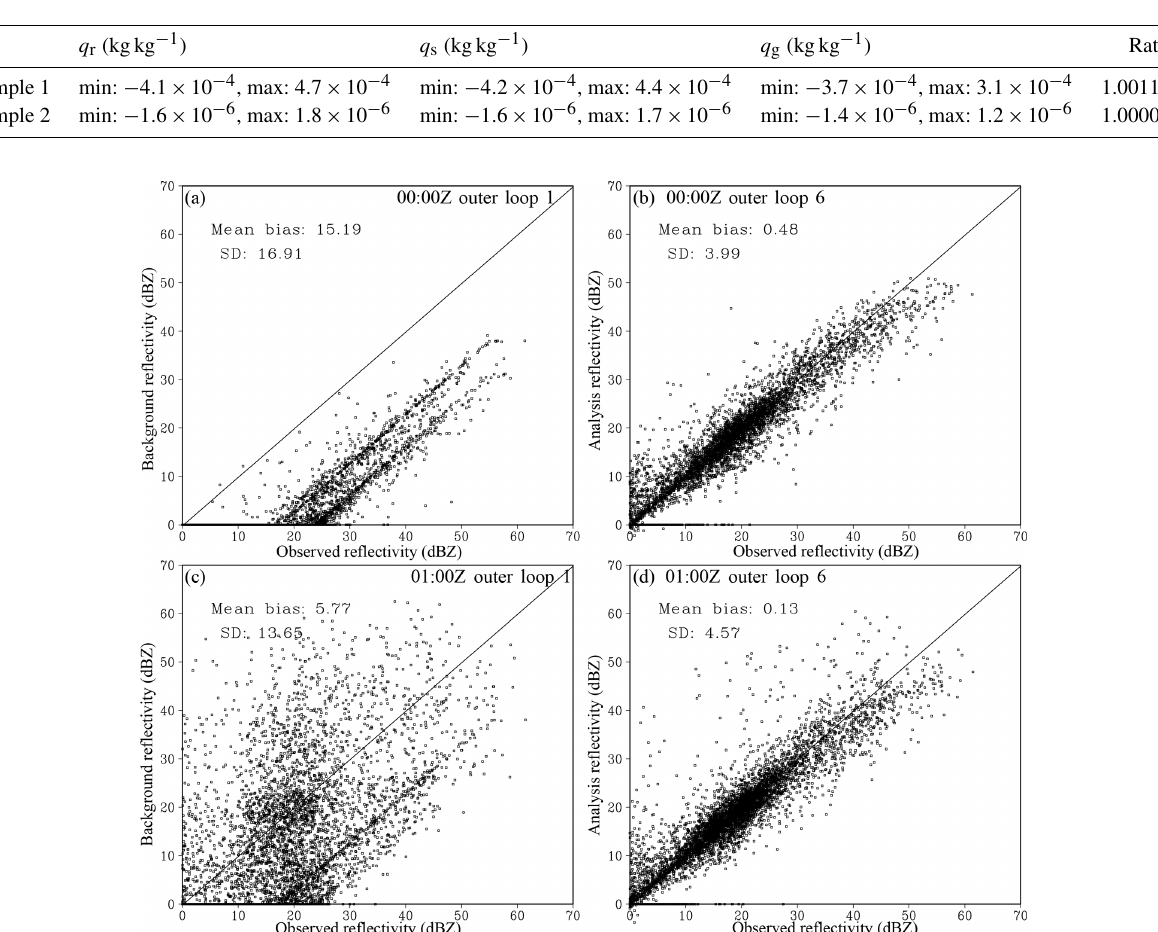
Table 3. Perturbation samples for the verification of the tangent linear operator.